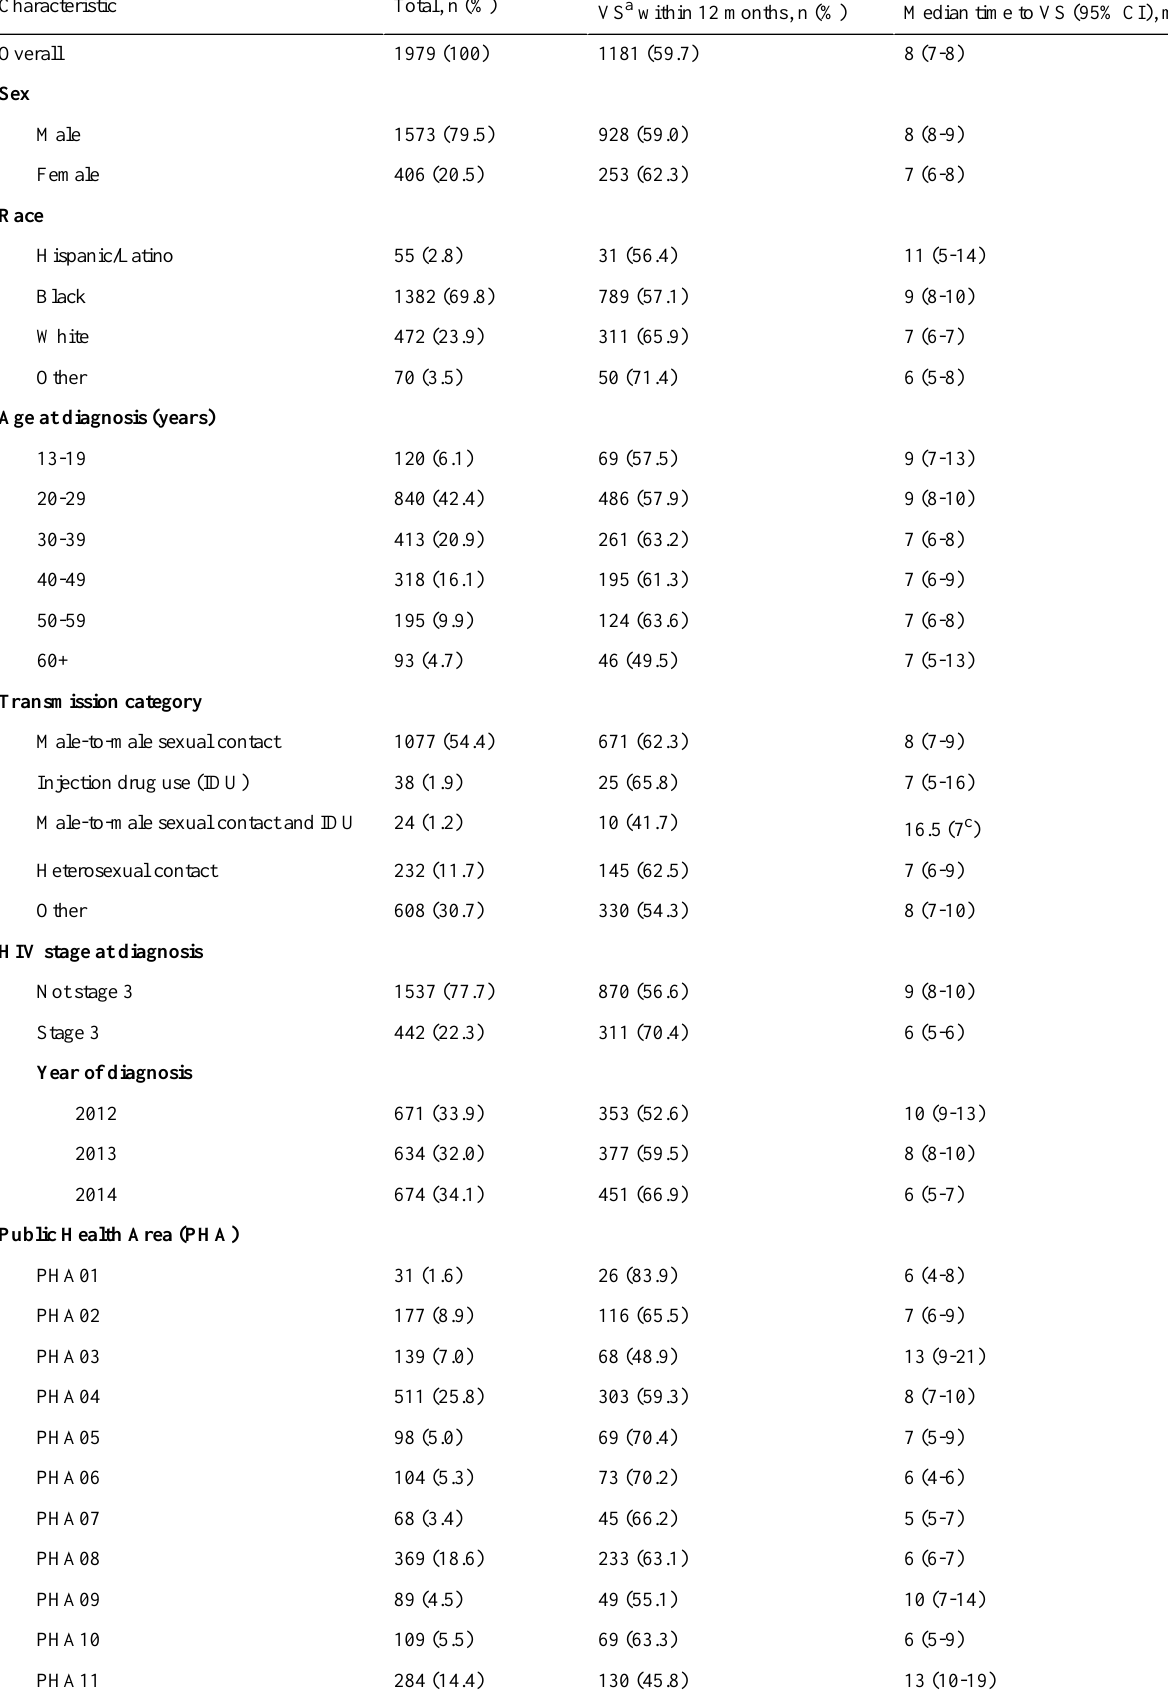
Table 1. Viral suppression among 1979 persons with newly diagnosed HIV aged 13 years and older in Alabama, 2012 to